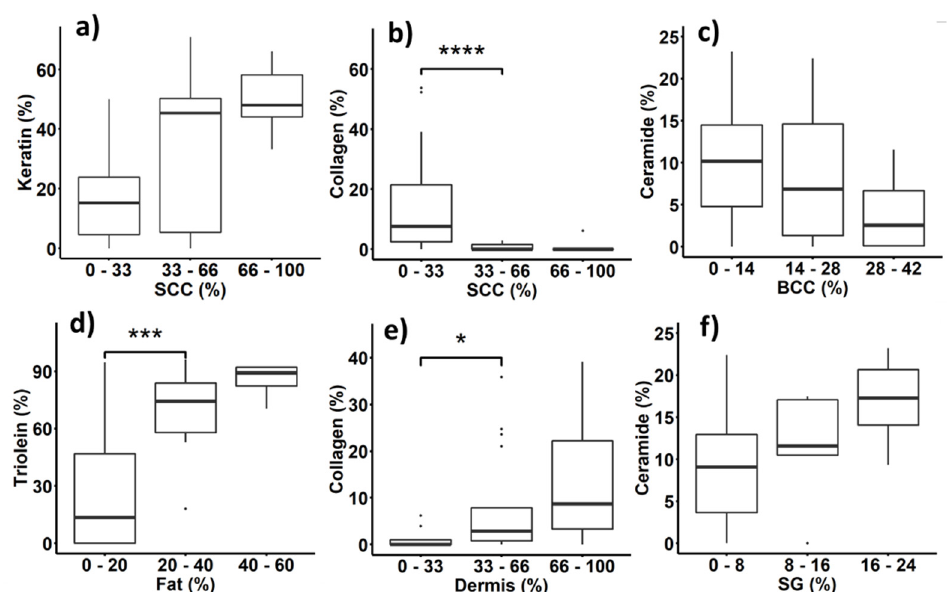
Figure 3. Contribution of biomarkers extracted from Raman spectra versus the percentage of tissue structures from histological analysis (total number of measurements is 82) in ( a ) Keratin vs. SCC, ( b ) Collagen vs. SCC, ( c ) Ceramide vs. BCC, ( d ) Triolein vs. Fat, ( e ) Collagen vs. Dermis and ( f ) Ceramide vs. SG. The percentages of tissue structures were divided equally into three sections for distribution comparison. Statistical analysis was performed via analysis of variance (ANOVA) combined with Tukey’s test as a post hoc analysis. Statistical significance notion: * p ≤ 0.05, ** p ≤ 0.01, *** p ≤ 0.001, **** p ≤ 0.0001.